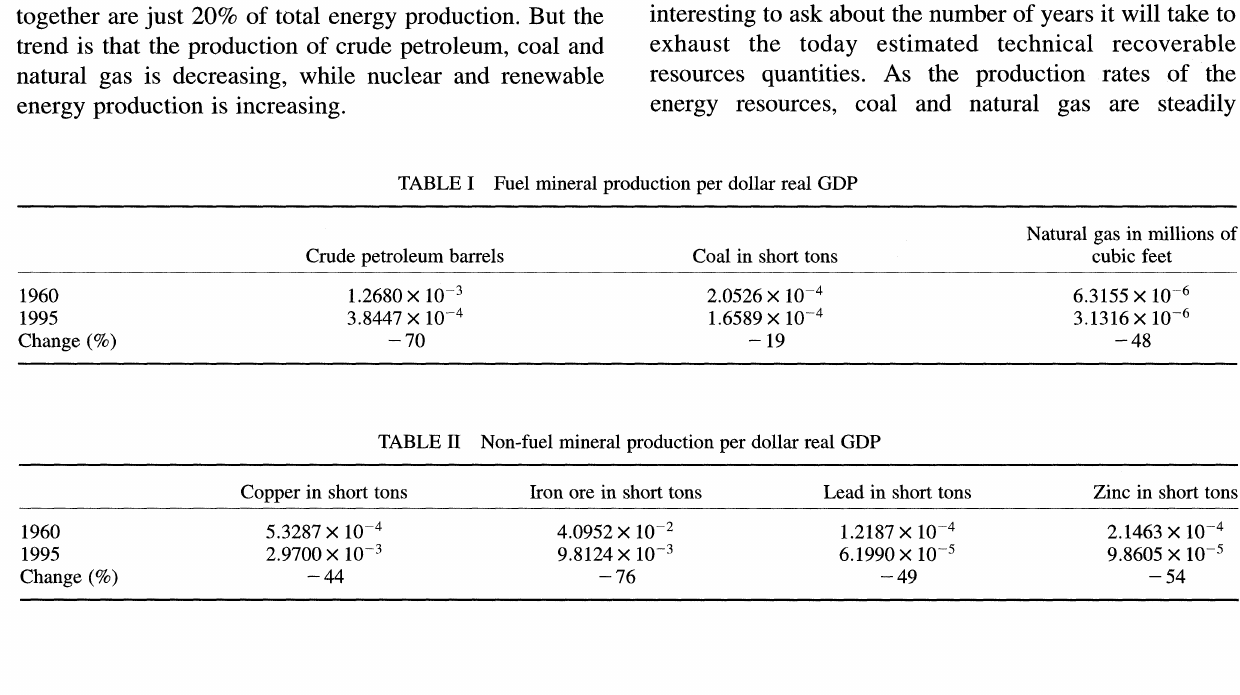
TABLE II Non-fuel mineral production per dollar real